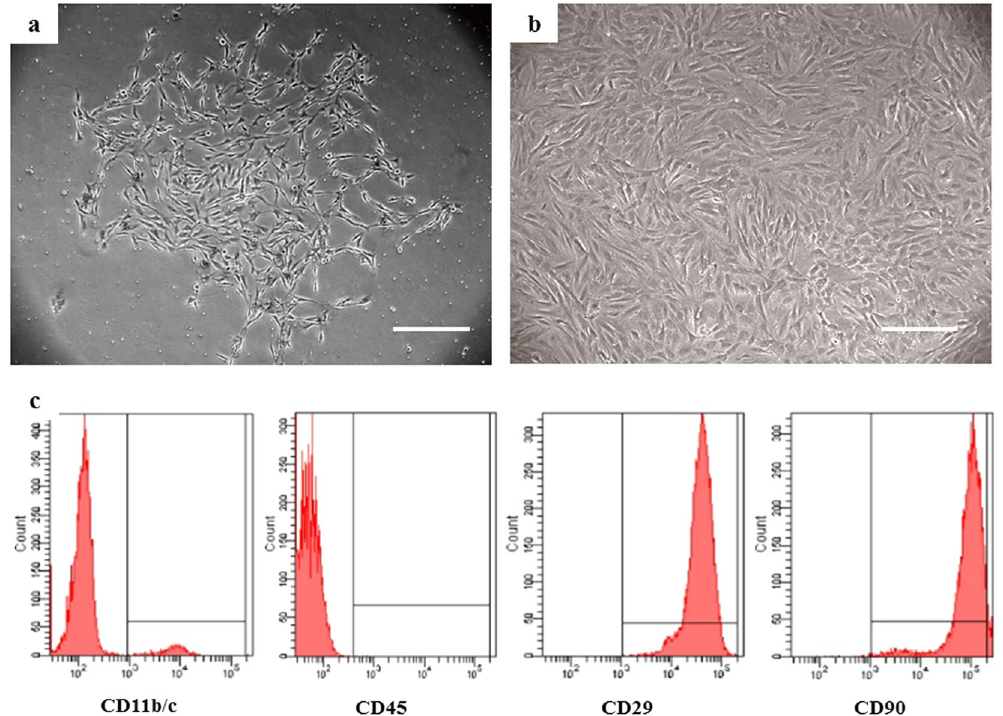
Figure 1. ( a ) Phase-contrast image of BMSCs colonies in the primary culture. Scale bar = 200 μ m. ( b ) Phase- contrast image of BMSCs after three passages. Scale bar = 200 μ m. ( c ) Fluorescent-activated cell sorting (FACS) analysis revealed that cells were positive for CD29 and CD90 expression and negative for CD11b/c and